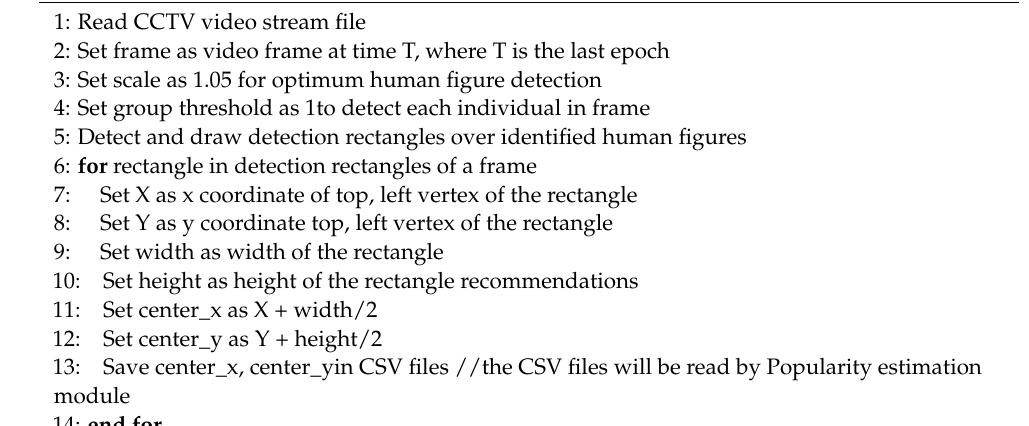
Algorithm 1 Pseudo-Code for visitor detection from a video streaming